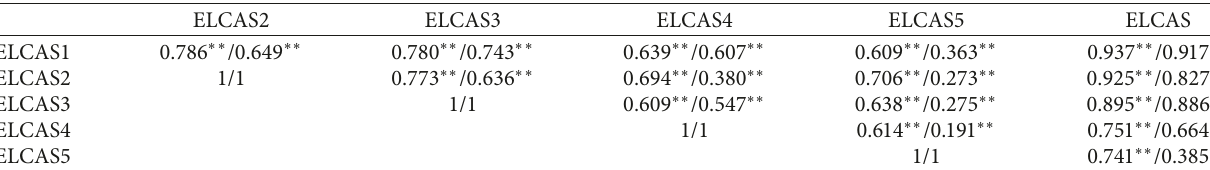
Table 4: Correlations between ELCAS scales ( N �